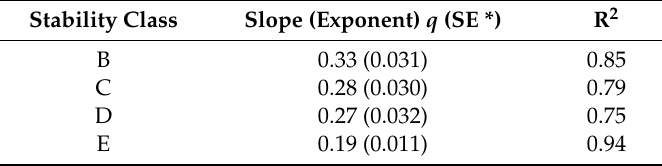
Table 4. Results of the regression for log(PMR_OI) = q log( t m / t p ) for di ff erent stability